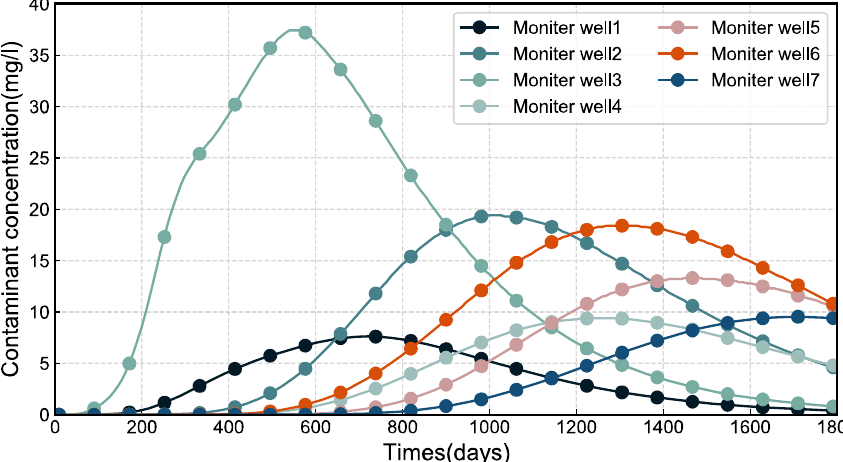
Figure 9. Observed data of contaminant concentration at each monitor well.